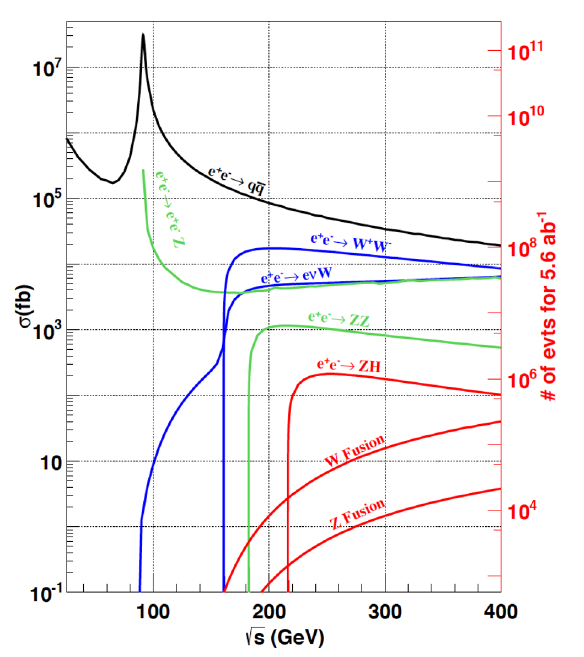
Figure 1 . The cross section for an unpolarized e + e − collision [10], the right side shows the expected number of events at the nominal parameters of the CEPC Higgs runs at 240 GeV centre-of-mass energy.